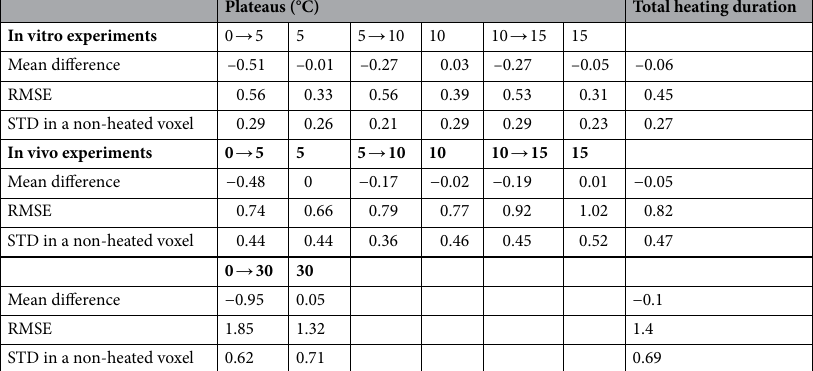
Plateaus (°C) Total heating